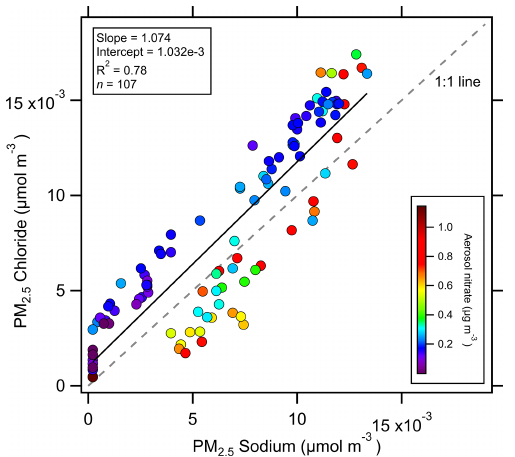
Figure 7. Correlation between PM 2 . 5 Na + and Cl − during the event shown in Fig. 6. Lower Cl − : Na + ratios were observed at higher NO − concentrations, suggesting HNO 3 uptake displaced 3